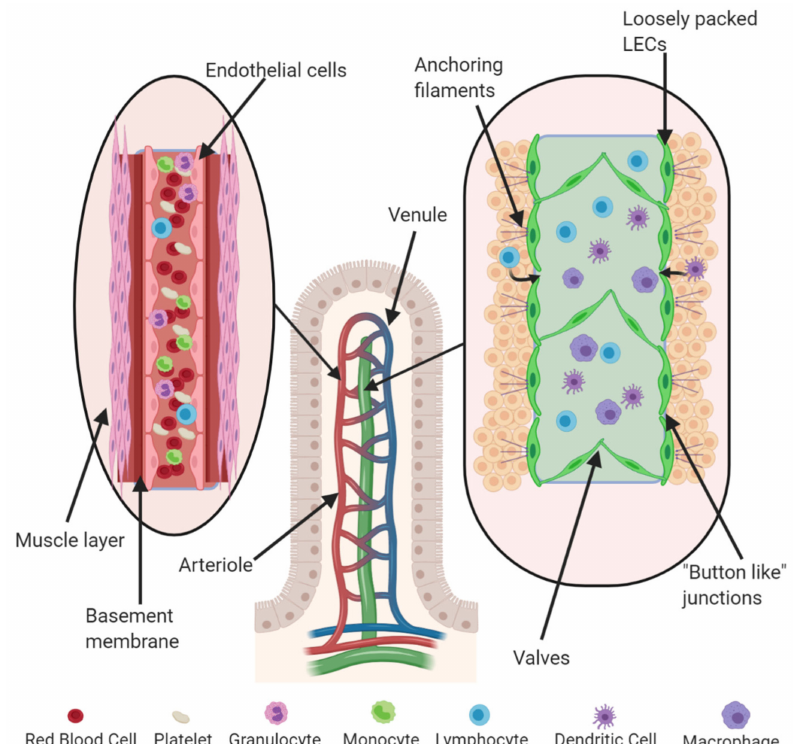
Figure 1. Structure of intestinal villus with associated vasculature and lymphatic vessels. The vascular endothelium loops around from arteries to veins and back to the heart. It contains endothelial cells tightly packed against each other, with an outer layer of smooth muscle cells to facilitate blood flow. Lymphatic vessels are composed of lymphatic endothelial cells (LECs), which are loosely packed to facilitate the exchange of lymph, which is then moved through the vessels by a system of valves. They are connected through “button-like” junctions and are anchored to the extracellular matrix (ECM) by anchoring